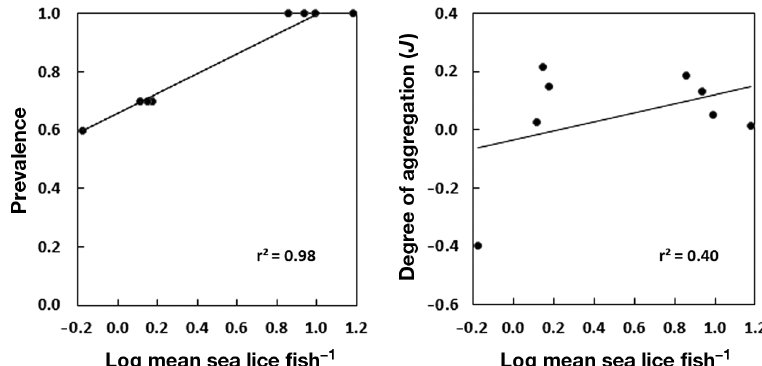
Fig. 3. Correlations between prevalence and log mean sea lice Lepeoph- theirus salmonis per salmon Salmo salar , and degree of aggregation and